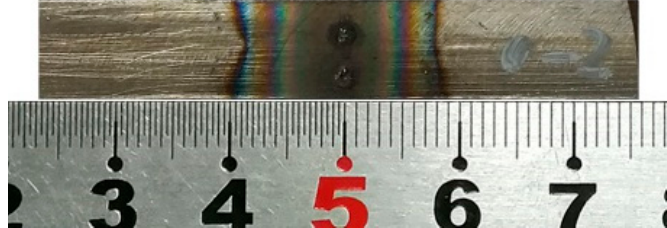
Figure 8. A photo of typical specimen after HAZ simulation using the Gleeble simulator with about a 10 mm width located at the center.